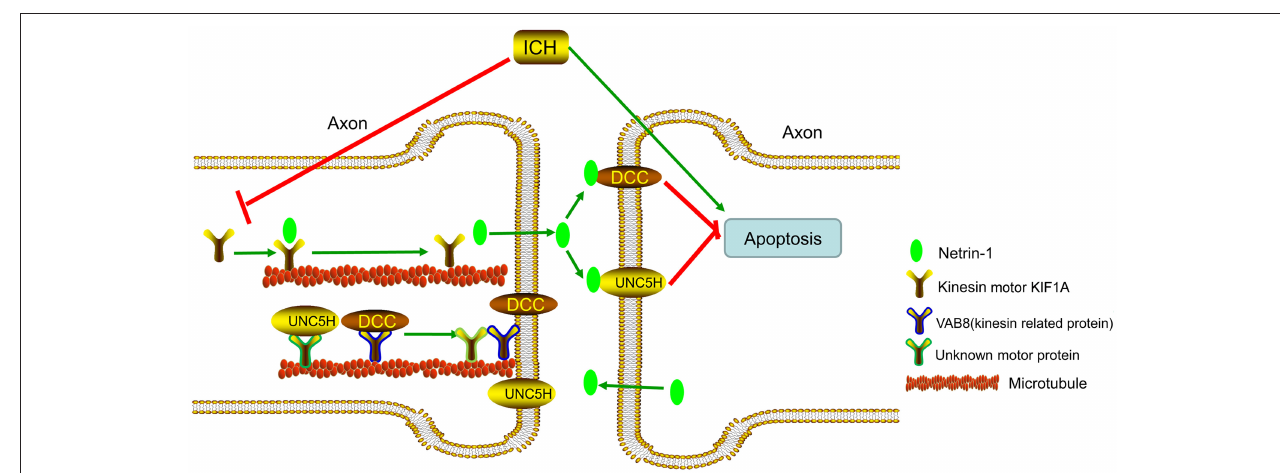
FIGURE 12 | Model illustrating possible mechanisms underlying the roles of kinesin motor KIF1A, netrin-1, and their interactions in SBI after ICH. The kinesin motor, KIF1A, serves as a transporter during netrin-1 secretion. KIF1A binds to netrin-1 and transports it to the axon. When ICH occurs, KIF1A is downregulated, which inhibits intracellular transport and secretion of netrin-1. This leads to a decrease in binding of extracellular netrin-1 to “dependence receptors,” DCC and UNC5H2. The increase in number of unliganded receptors triggers apoptotic signal transduction and subsequent cell death. This pathological process aggravates SBI after ICH. Therefore, upregulation of KIF1A or administration of exogenous netrin-1 may inhibit ICH-induced SBI.